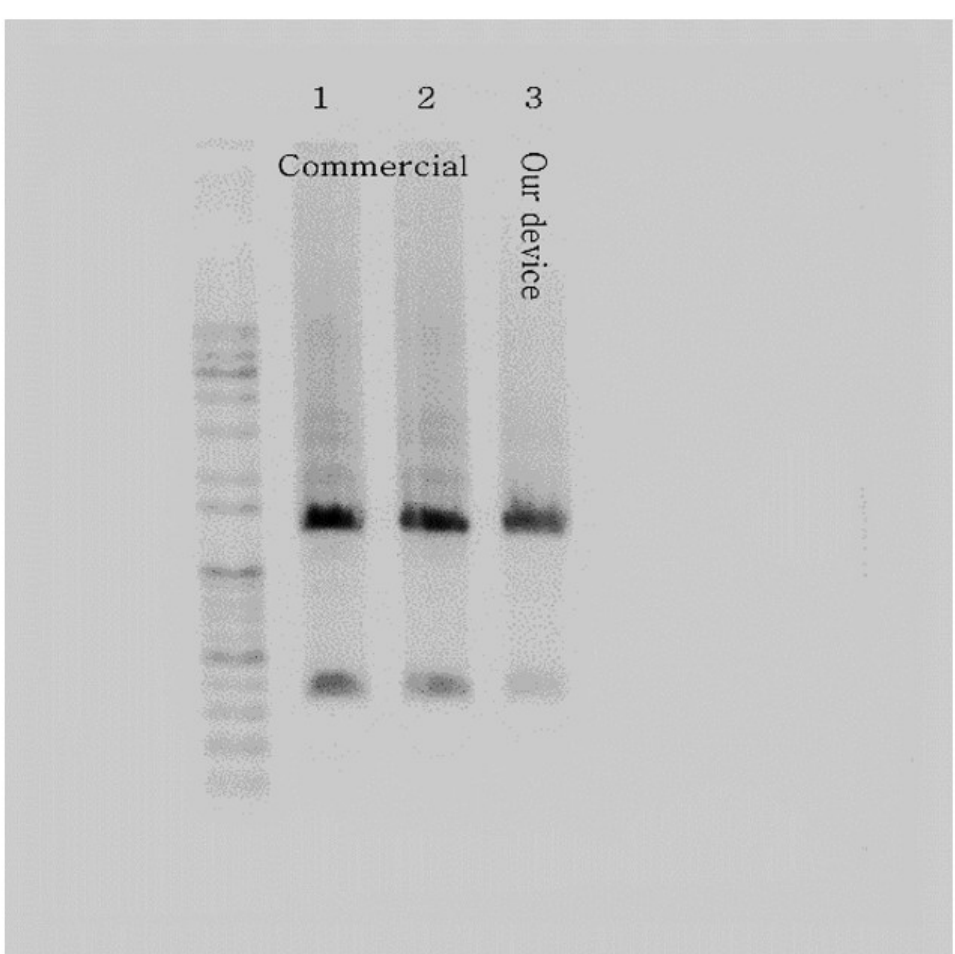
Figure 9. Gel electrophoresis results verify the PCR device with the microchip heated by the chip resistor. The picture shows strong bands of ZFP36 DNA amplified using a commercial PCR machine (samples 1 and 2) and our PCR device (sample